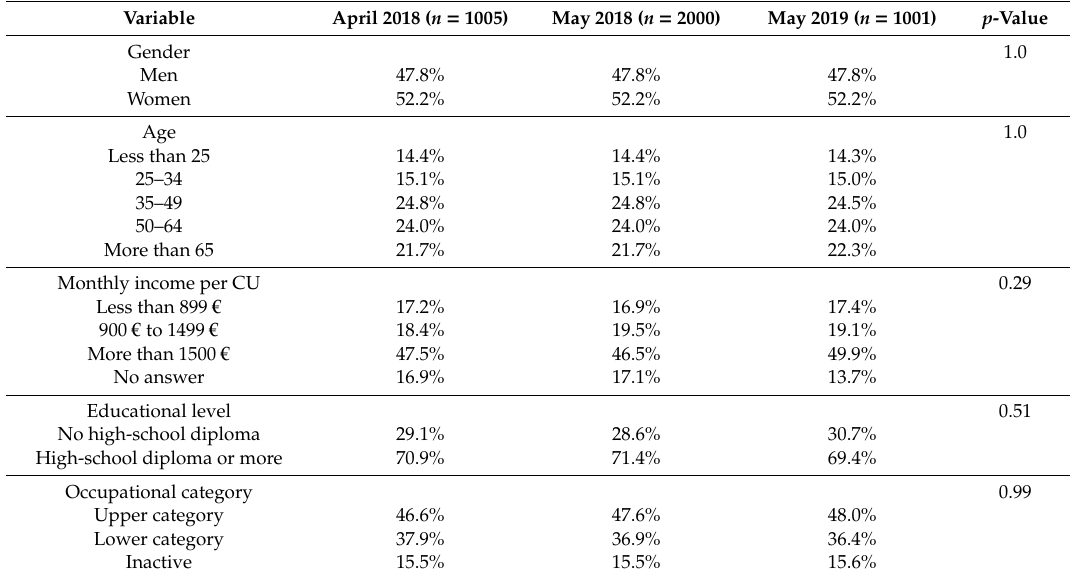
Table 1. Individual characteristics of participants across the three successive questionnaires (weighted data).